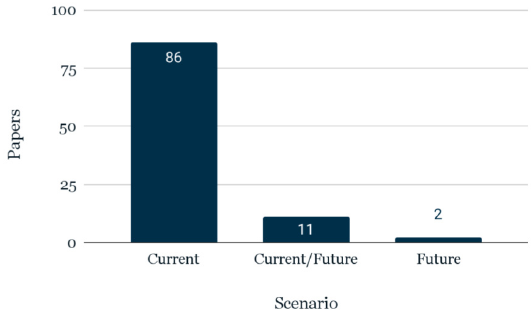
Figure 21. Histogram of publications in this review concerning future climate scenarios.